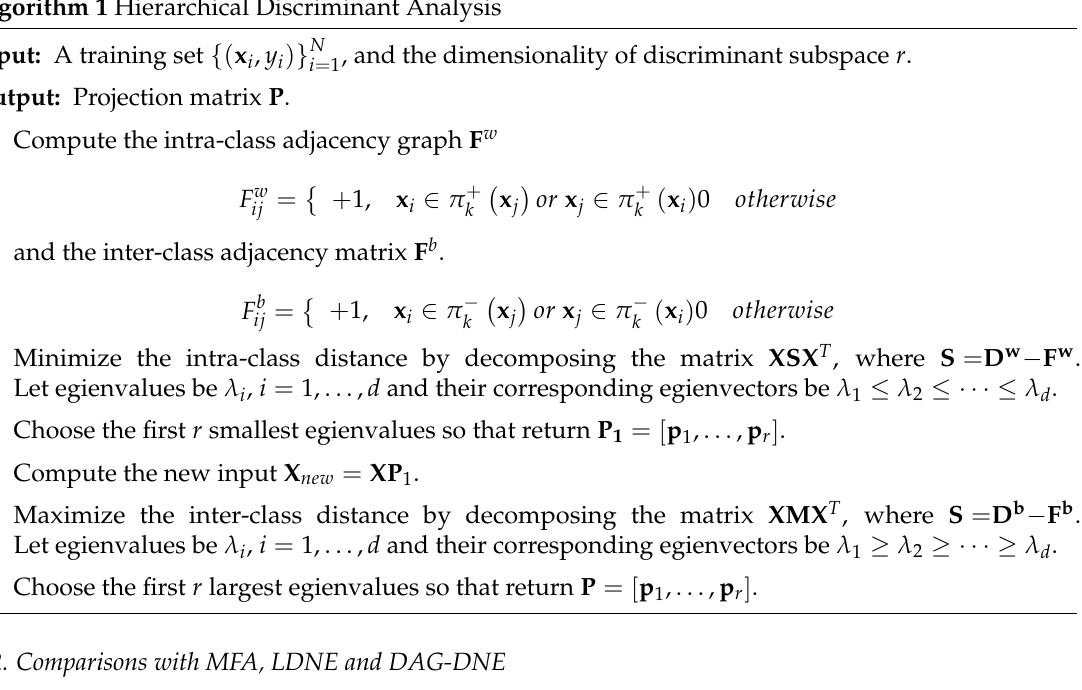
Algorithm 1 Hierarchical Discriminant